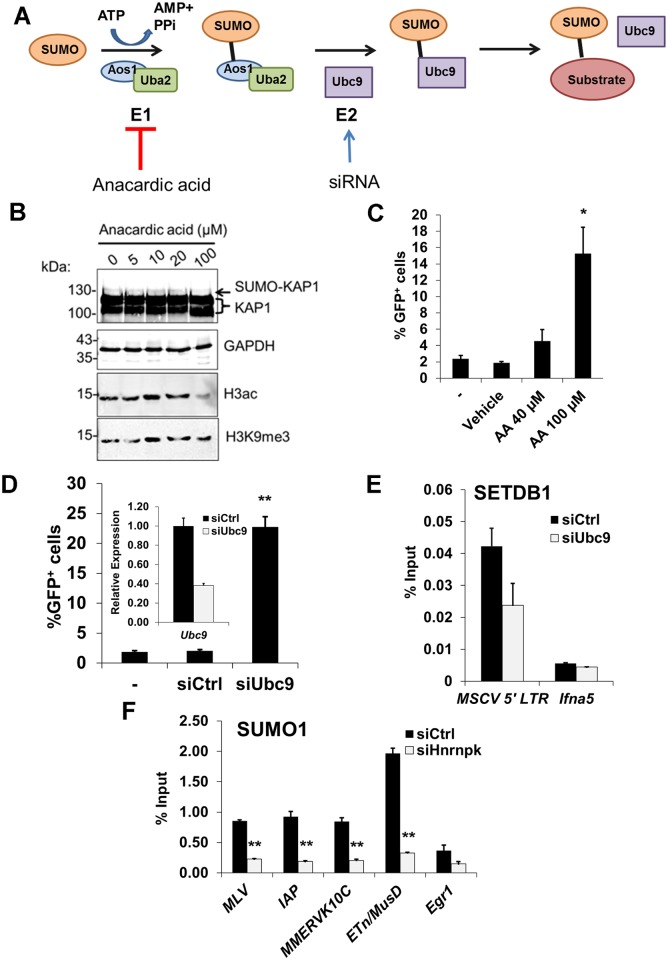
SUMOylation on proviral chromatin is required for SETDB1 recruitment and is compromised upon hnRNP K knockdown.(A) Illustration of the SUMO conjugation pathway including the activities of SUMO E1 activating heterodimer enzyme Aos1/Uba2 and SUMO E2 conjugating enzyme Ubc9. Anacardic acid was used to inhibit E1 activity while siRNAs were used to deplete Ubc9 transcripts to disrupt SUMO conjugation in the MSCV-GFP cell line. (B) Western blot analysis of KAP1, GAPDH, pan Histone H3 acetylation or H3K9me3 in MSCV-GFP cells incubated in varying concentrations of anacardic acid for 18 h prior to harvest. A mono-SUMOylated KAP1 band is detected at ~130 kDa (arrow). (C) Flow cytometry for GFP+ cells in the MSCV-GFP line alone (-), vehicle (DMSO) treated, or treated with 40 or 100 μM anacardic acid for 18 h. Data are mean of three biological replicates for 10,000 PI- cells per sample, error bars are s.d. (D) Flow cytometry data as in (B) except on cells untransfected (-) or transfected with control or Ubc9 siRNAs at 48 h post-transfection. Inset, qRT-PCR analysis of Ubc9 expression in cells transfected with control or Ubc9 siRNAs at 24 h post-transfection. Data are mean relative expression levels determined from three technical replicates, normalized to the level of β-actin (Actb) transcripts, error bars are s.d. (E) Crosslinked ChIP of SETDB1 on unsorted (GFP+ and GFP-) MSCV-GFP cells transfected with control or Ubc9 siRNAs at 48 h post-transfection. Data are mean enrichment as a percent of input chromatin from three technical replicates, error bars are s.d. (F) Crosslinked ChIP as in (E) except for SUMO1 on TT2 cells transfected with control or Hnrnpk siRNAs at 24 h post-transfection. *p < 0.01, **p < 0.001, Student’s two-tailed T-test relative to vehicle or siCtrl.